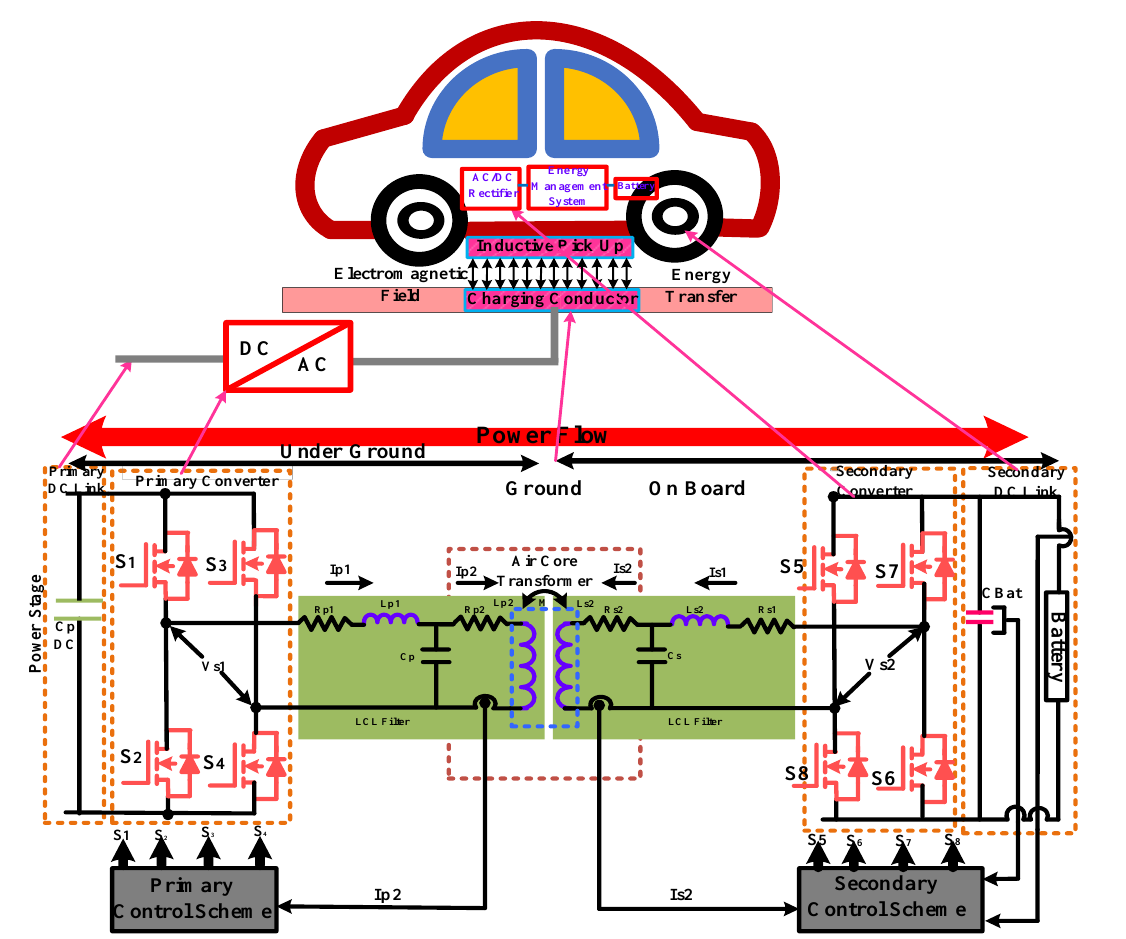
Figure 7. Bidirectional Wireless Power Transfer for hybrid compensation of (LCL-IPT) system.